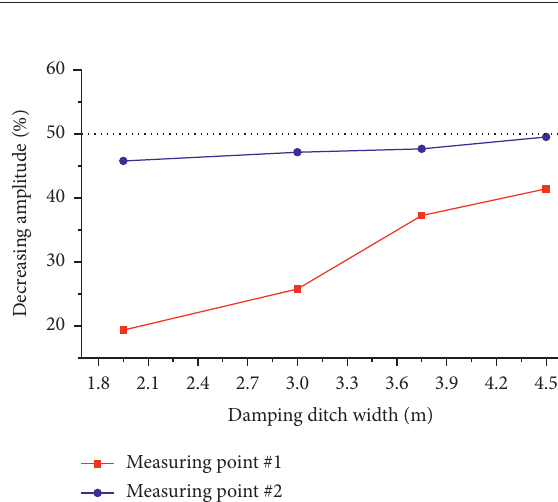
Figure 9: Influences of three damping ditch parameters on the PPV.